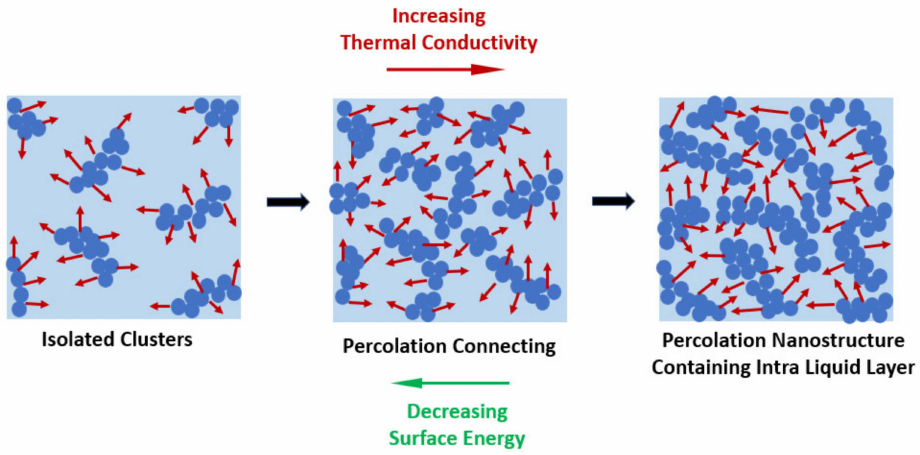
Figure 8. Schematic diagram of the percolation mechanism of